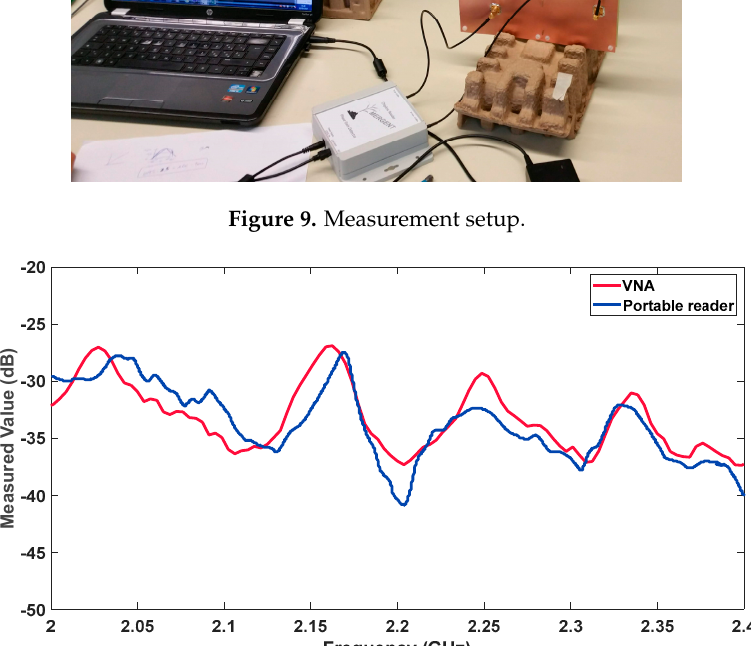
Figure 10. Measured response of the four-bit depolarizing tag; comparison between the portable chipless reader and the VNA (Vector Network Analyzer).